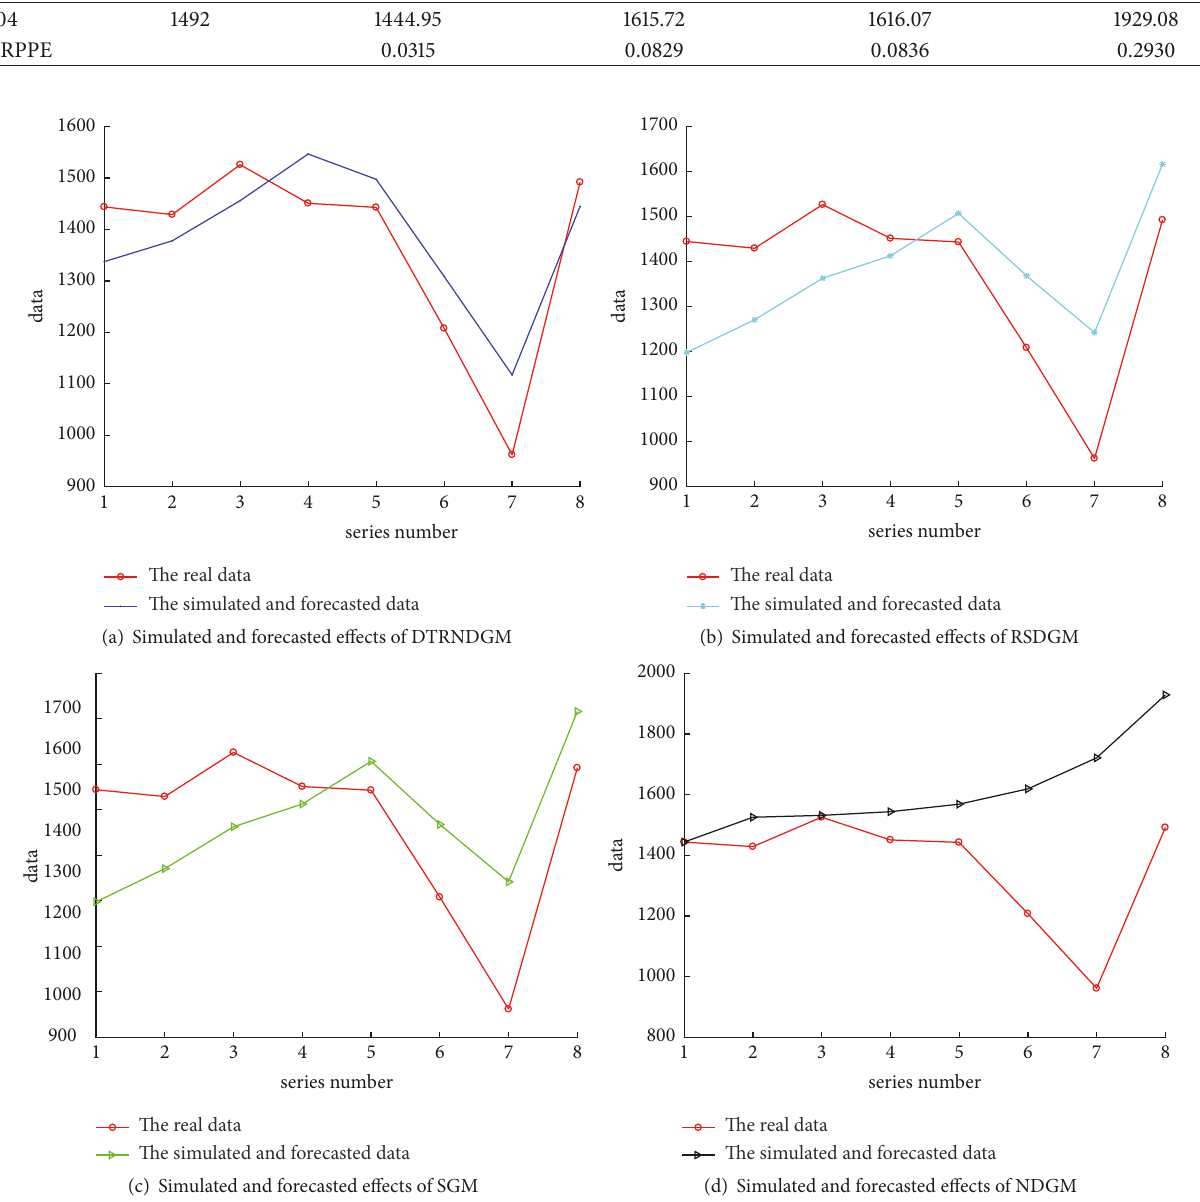
Figure 4: Simulated and forecasted effects of the four